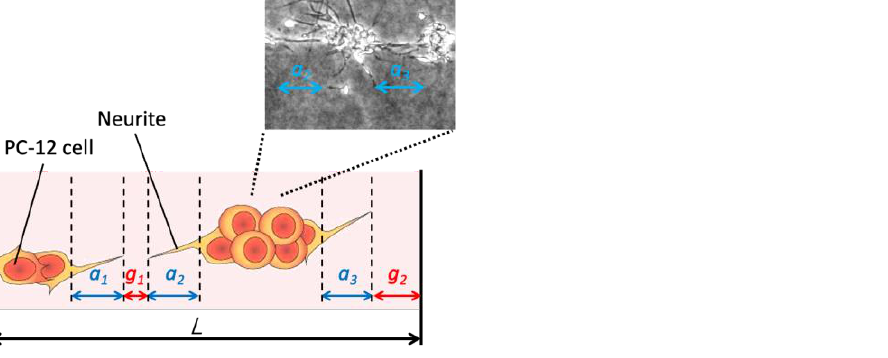
Figure 4. Evaluation of neurite formation of PC-12 cells and continuity of cellular pattern in a colla- gen gel. Neurite length was defined as the length of neurites connecting to adjacent cell aggregates.